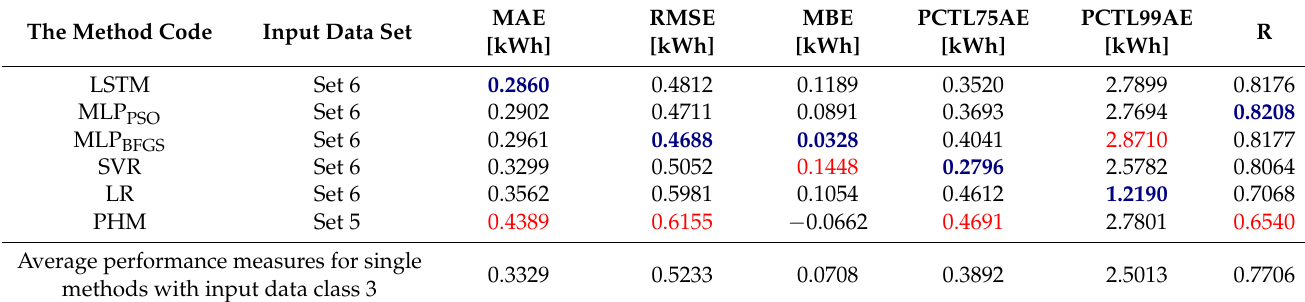
Table 9. Performance measures for single methods with input data class 3.